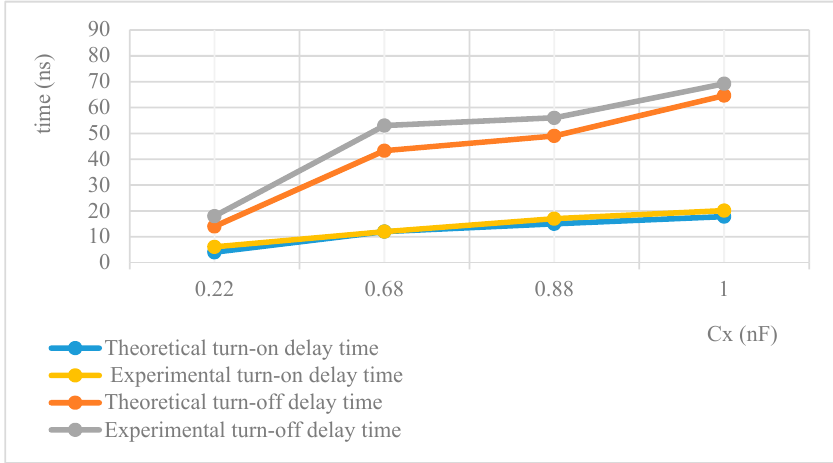
Figure 13. Comparison of t d-on-CX and t d-off-CX between experimental results and calculation results.